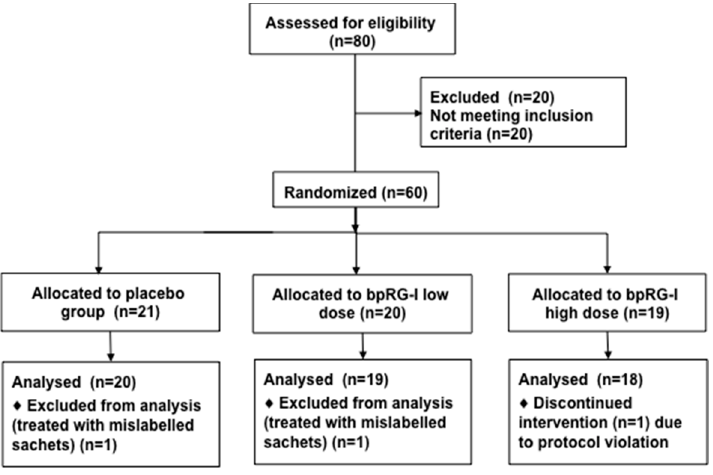
Figure 6. Disposition of subjects.